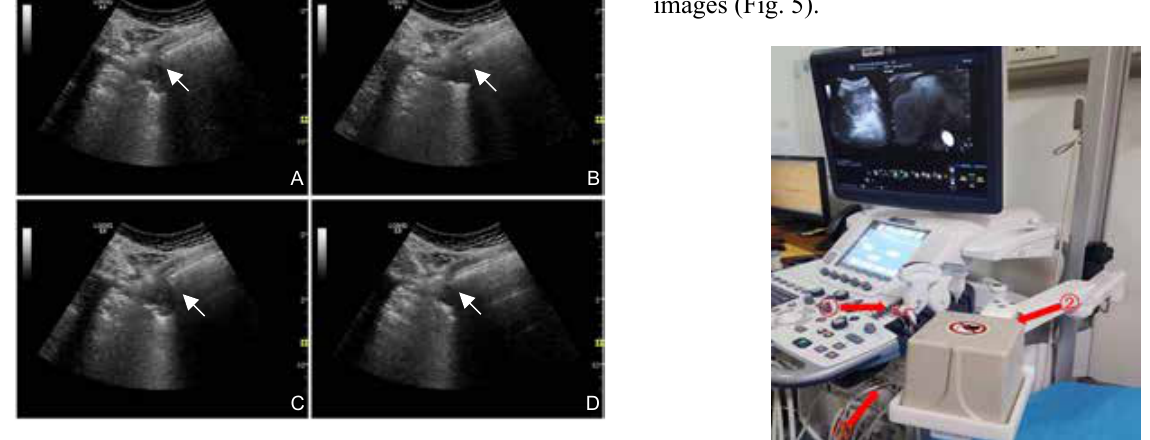
Figure 2 The ultrasonography shows a hypoechoic nodule close to the chest wall in the right lung upper lobe at different breathing phases (A, B, C and D). The arrow shows some part of the lesion was covered by the lung and could not be shown on ultrasound at different breathing phases.